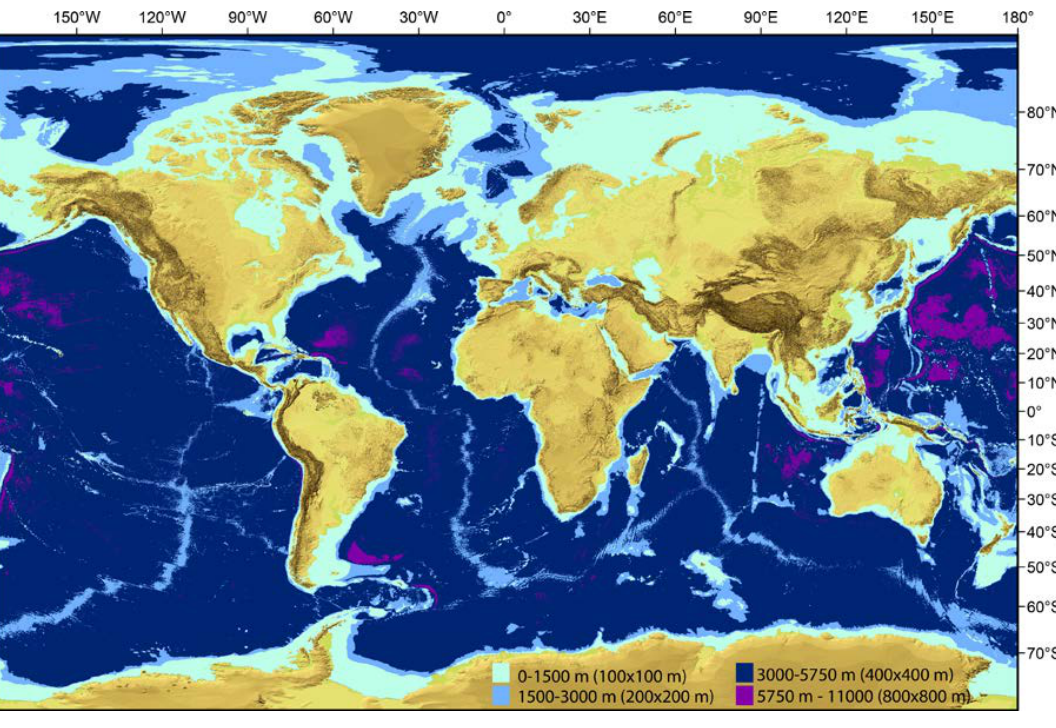
Figure 7. Depth regions based on state-of-the-art 2° × 2° deep-water multibeam installed on surface vessels, calculated at 60° from nadir shown in Table 2. Table 2. Feasible resolution based on state-of-the-art 2° × 2° deep-water multibeam installed on surface vessel, calculated at 60° from nadir.